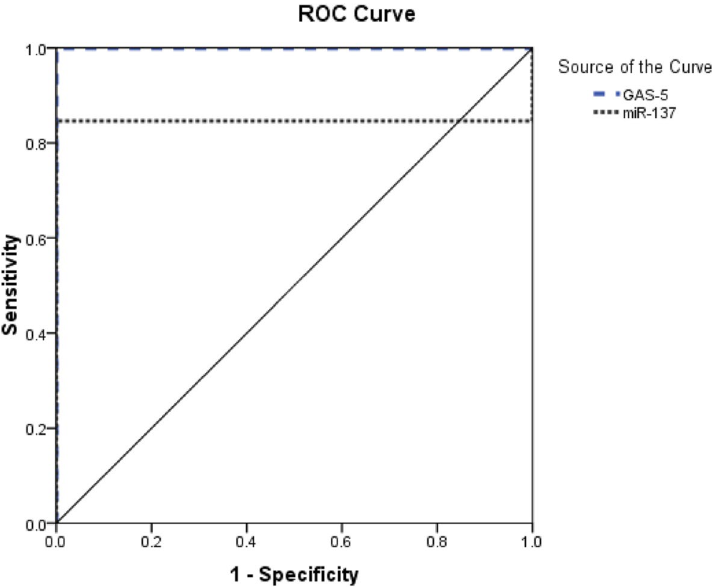
Figure 2. ROC curve demonstrates the role of lncRNA growth arrest-specific 5 (GAS5) and microRNA 137 (miR-137) in diagnosis of chronic viral hepatitis B cases.